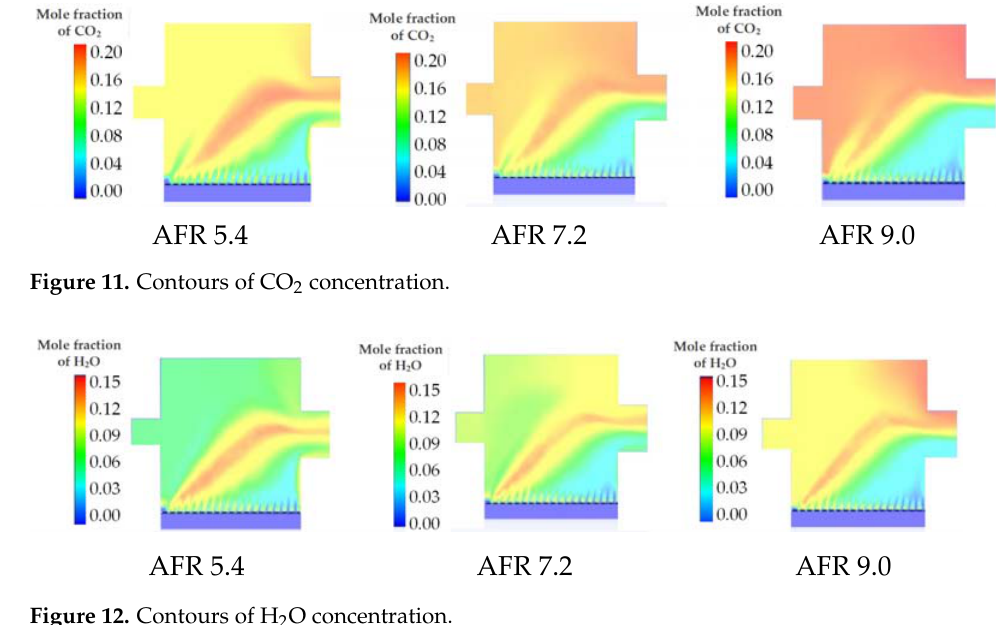
Figure 12. Contours of H 2 O concentration.